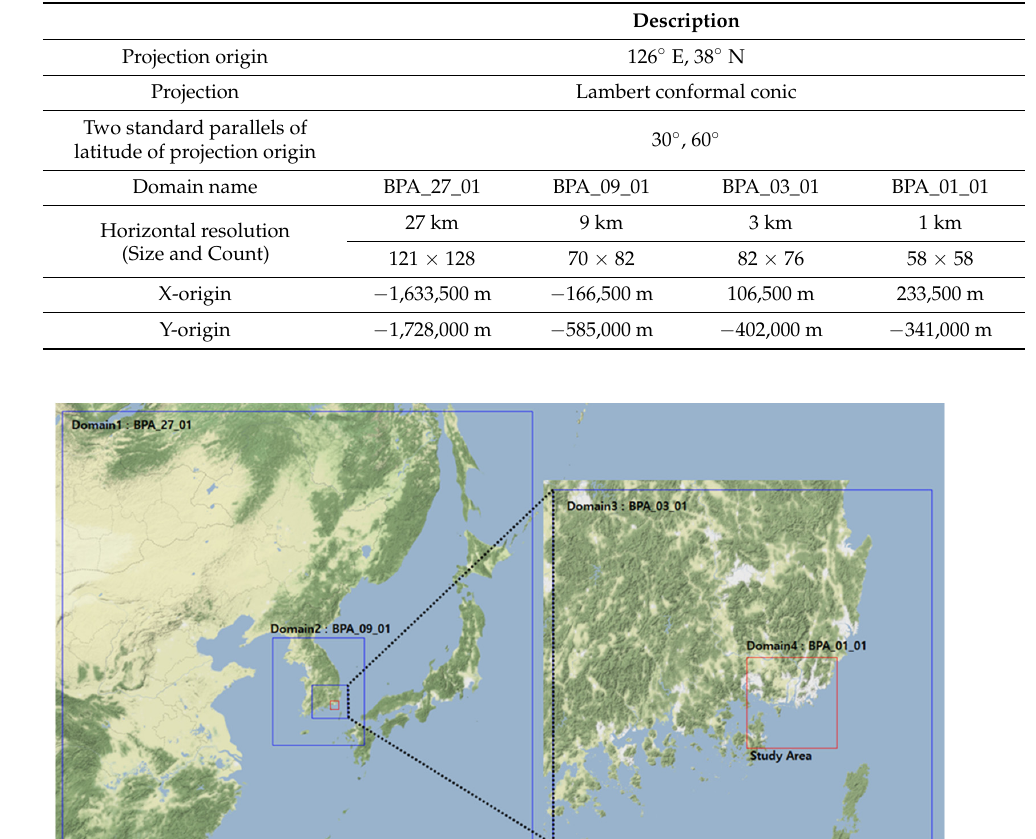
Figure 1. Conceptual diagram of the hybrid model system. Table 1. CMAQ modeling area and GRID configuration.